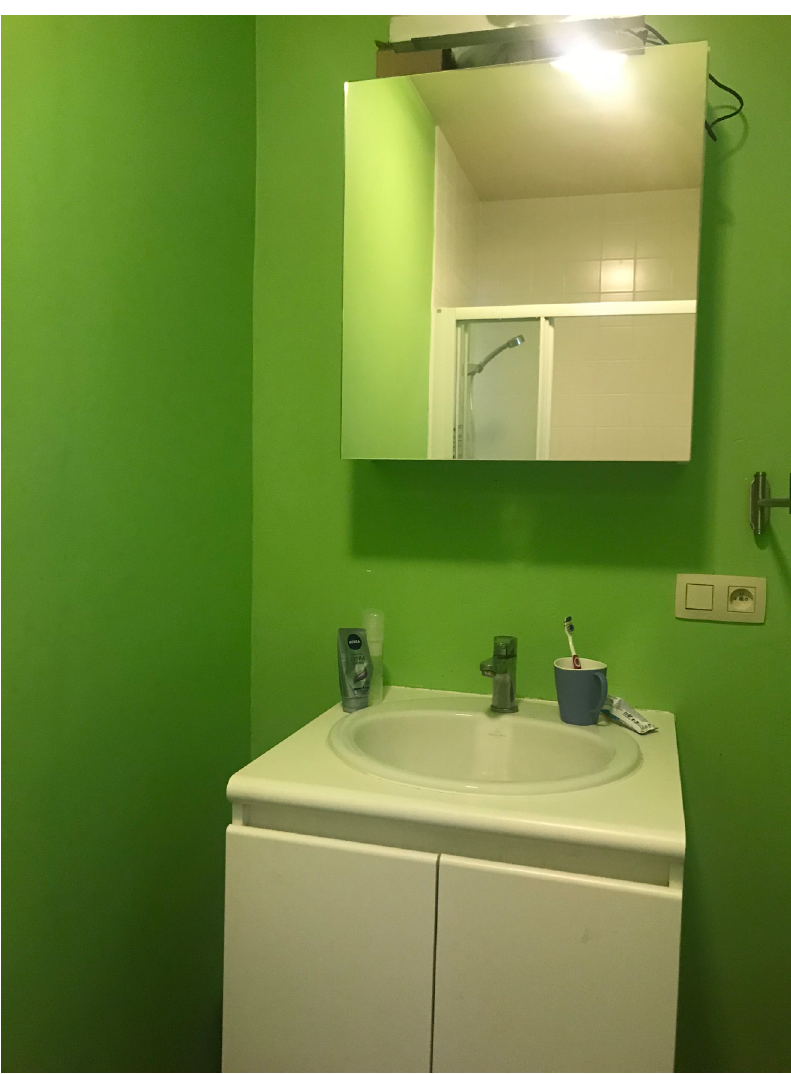
FIG. 6 Flashy colors for toilet and bathroom in Steve’s apartment.